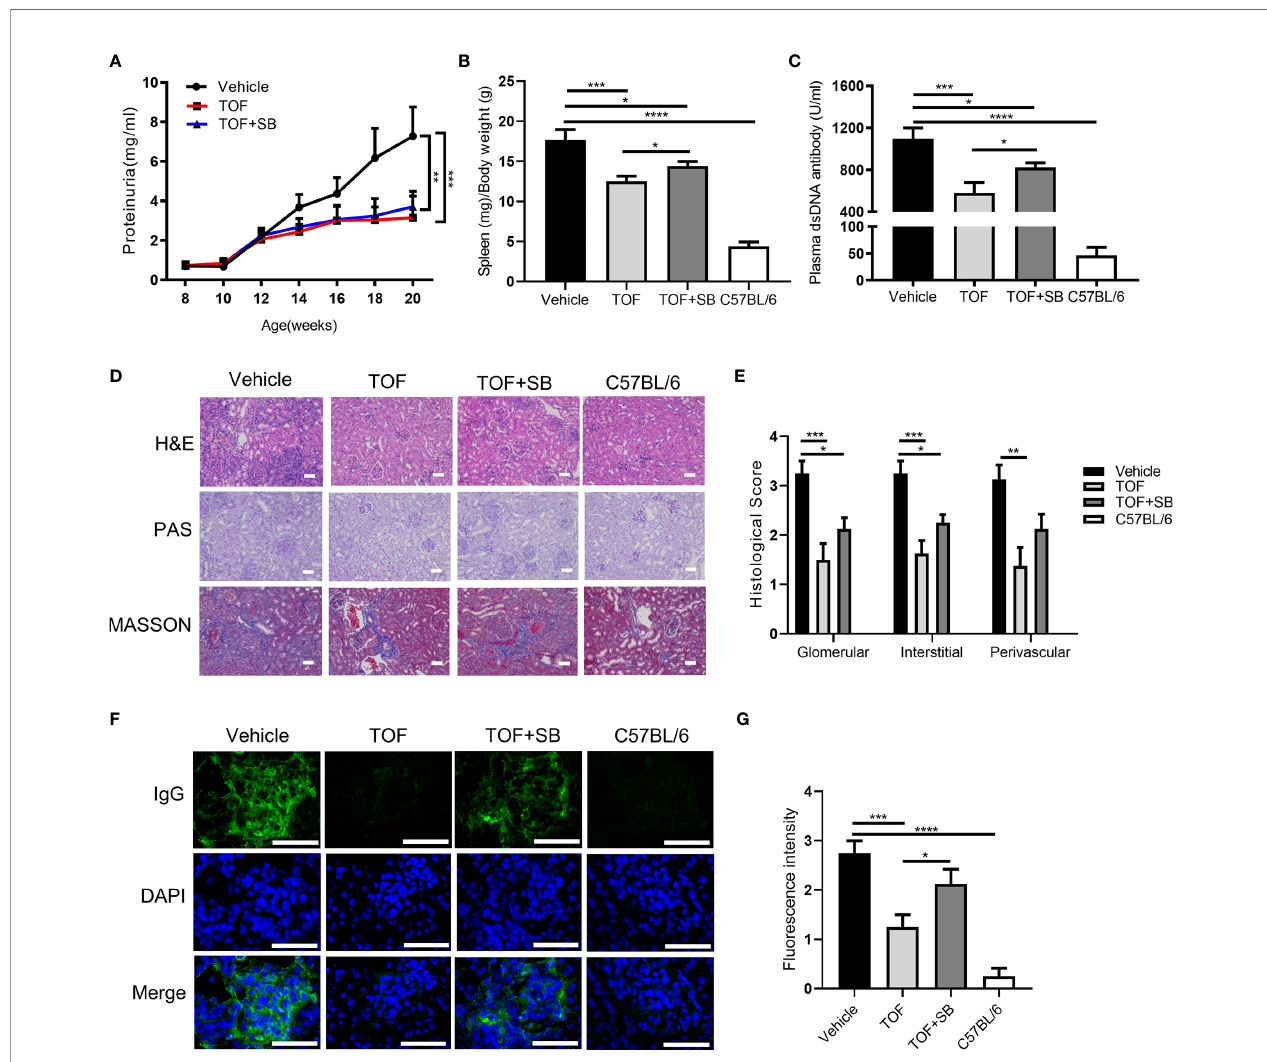
FIGURE 4 | Tofacitinib ameliorates the clinical symptoms and lupus nephritis in MRL/lpr mice. MRL/lpr mice were administered vehicle, tofacitinib alone or combined with SB431542. C57BL/6 mice were the control mice. (A) The levels of proteinuria were measured every two weeks. The spleen/body weight ratio (B) and plasma anti-dsDNA antibody level (C) were determined at the end of the study. (D) Representative photomicrograph of renal histology stained with hematoxylin and eosin (H&E), periodic acid-Schiff (PAS), and Masson. Scale bar, 30 µm. (E) Histological scores for glomerular, interstitial, and perivascular lesions, according to the above three stains. The control mice did not present any histopathological alteration and the histological score was zero. (F, G) Representative images of IgG deposition and fl uorescence intensity assessment. Scale bar, 50 µm. n=8 for each group. Error bars indicate SEM. * P <0.05, ** P < 0.01, *** P < 0.001 and **** P < 0.0001. TOF, tofacitinib; SB,